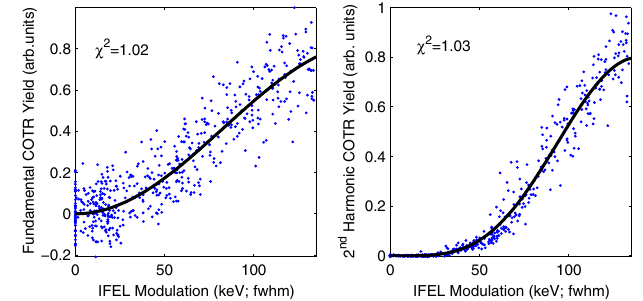
FIG. 3. (Color) Scatter plot of COTR signals versus IFEL modu- lation for a single run. Each point is a single interaction of the laser and electron beam. The amplitude of the IFEL interaction varies due to the delay scan. The solid lines give the analytic form [Eq. (7)].